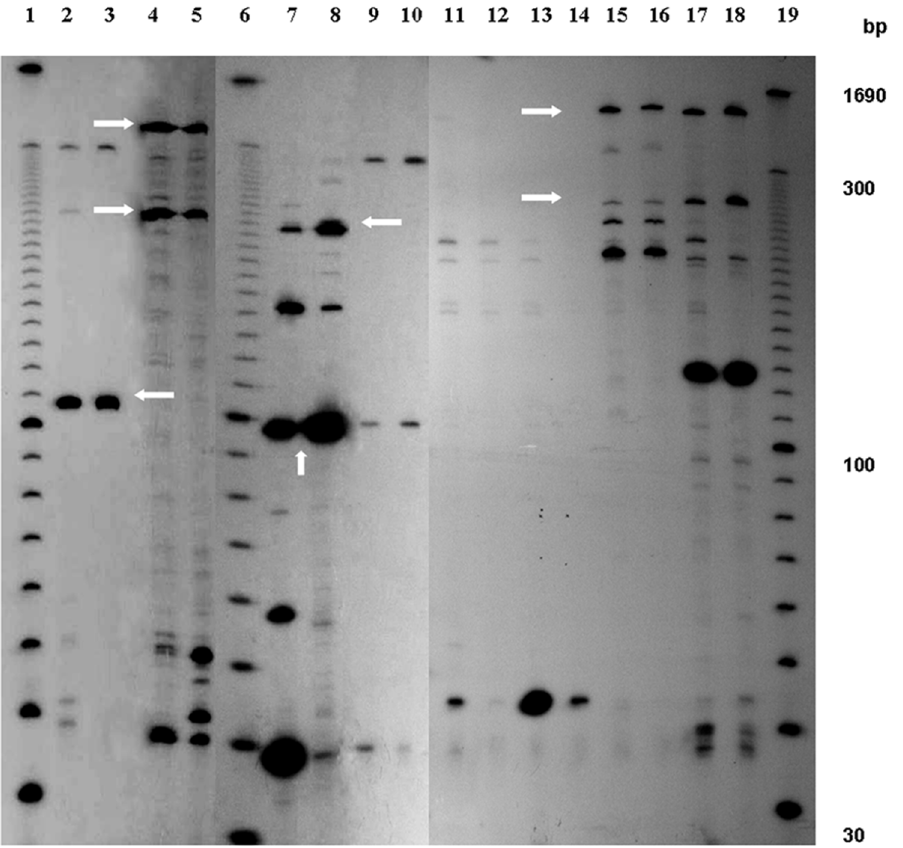
Figure 2. Representative cDNA AFLP Differential Gene Expression Profiles. Between R. indica infested with L. erysimi (Lanes: 2, 3, 7, 8, 11, 12, 13, 14) and uninfested R. indica (Lanes: 4, 5, 9, 10, 15, 16, 17, 18) samples using different primer combinations. Lanes 2, 3, 4, 5 with E-AAC/M-CAT; Lanes 7, 8, 9, 10 with E-AAC/M-CAG; Lanes 11, 12, 13, 14, 15, 16, 17, 18 with E-AAC/M-CTG. Differential bands are indicated by arrows. Lanes 1, 6 and 19 are for 30–330 bp marker AFLP DNA ladder. It is a 6% denaturing polyacrylamide gel.